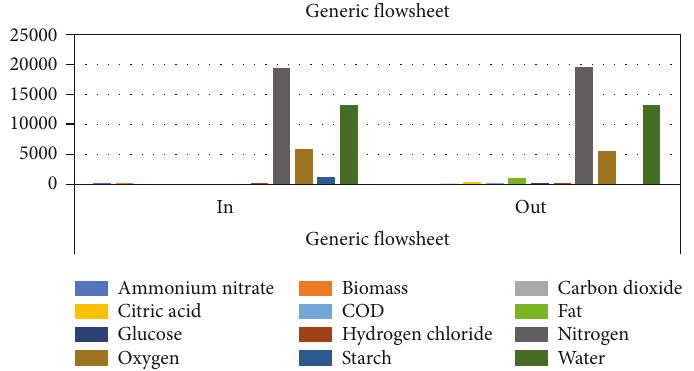
Figure 5: Generic Flowsheet Comparison. Table 4: Energy and Utility